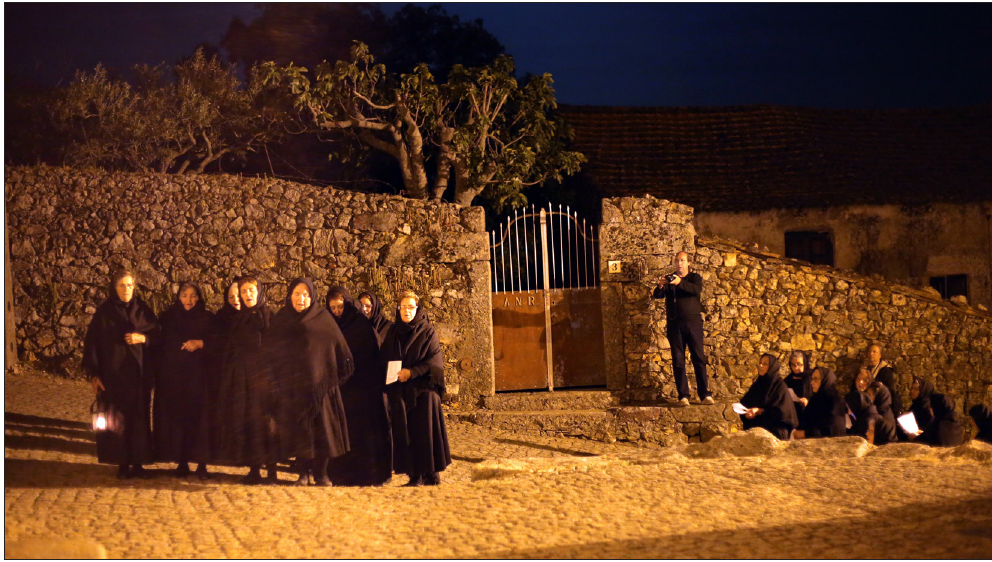
Figure 1: The religious group of Penha Garcia doing the “Louvado Nocíssimo”, which is one of the local Lenten traditions. Once the groups have completed the ritual, they gather to start commending the souls. The City’s heritage program, en- titled Páscoa na Idanha (Easter in Idanha), includes all these Lenten and Easter rituals practiced across the municipality. (Photo: Pedro Antunes,